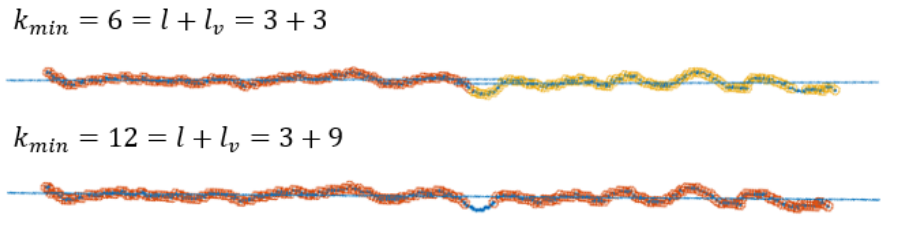
Figure 12. The effect of increasing k min and n buf is shown in the greater probability of outlier detection and in the reduction in over-segmentation according to Equation (20), where k max = 2.